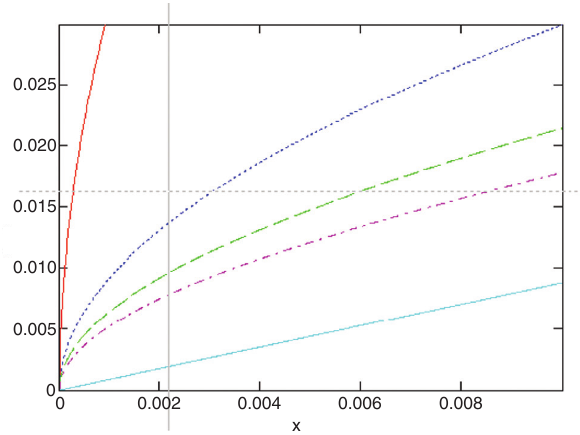
Figure 7 Plot of crack profile near the tip in the (red) classical case and in the cases (blue) n = 1; (green) n = 5; (magenta) n = 9; (cyan) gradient elasticity profile, Eq. (6). All approximations generate the same parabola-like crack profile with a strain singularity, which is removed only in the limit n →